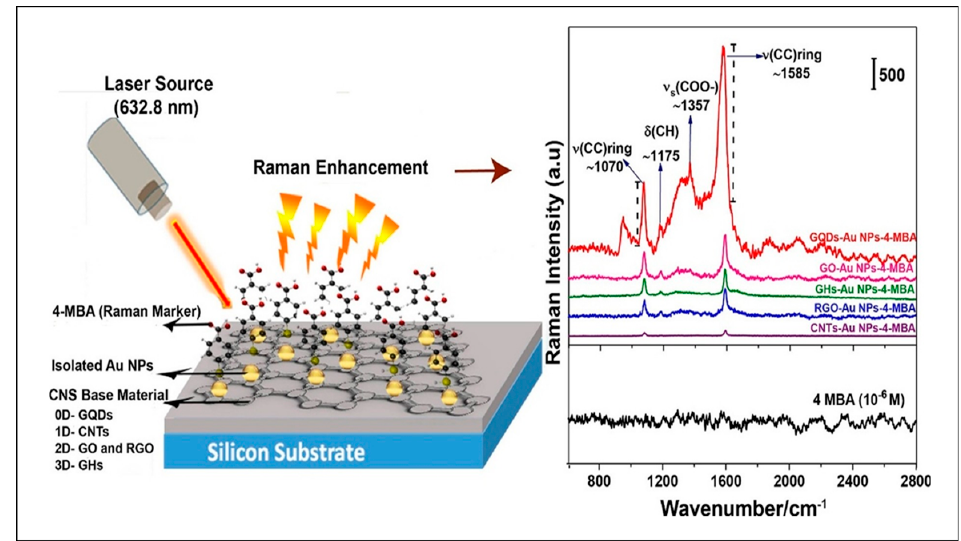
Figure 10. Schematic of a carbon-based SERS substrate of various functional groups. ( left ). SERS spectra of the analyte 4-mercaptobenzoic acid (MBA) adsorbed on the scaffolds ( right ). (Reproduced from Ref. [113] with permission from Springer).